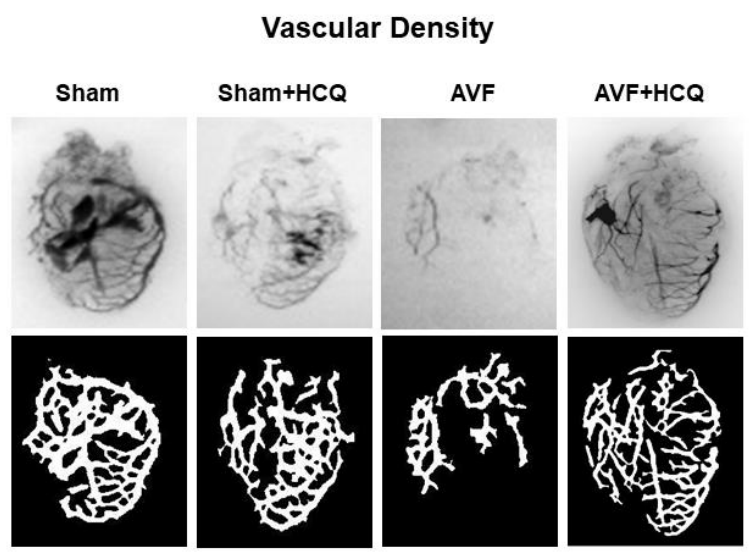
Figure 7. Representative barium X-ray angiography and vascular density from the hearts from sham, and AVF treated with and without HCQ: n = 5–8 in each group.